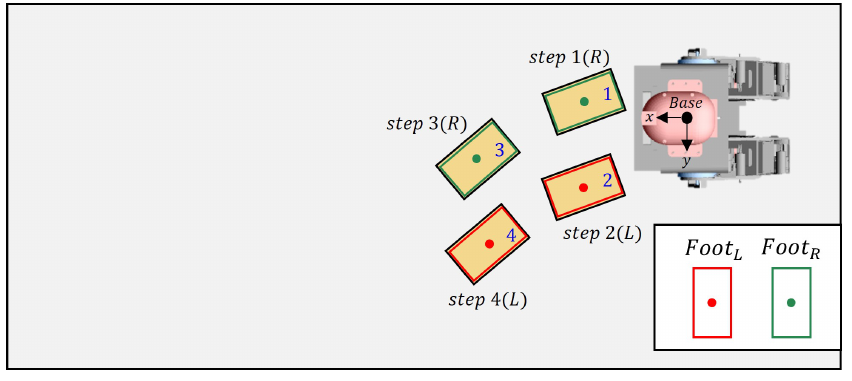
Figure 20. Top view of Scene 3.